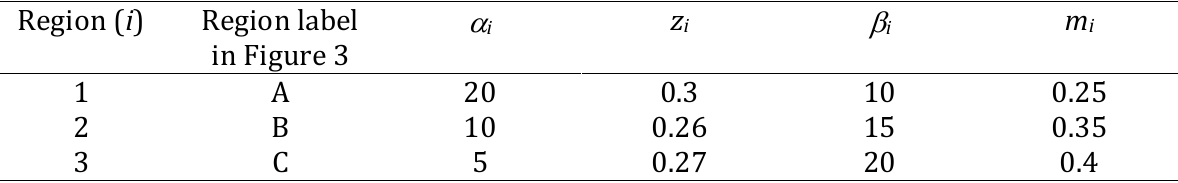
Table A1.1: Parameters used to simulate three distinct ecological regions ( i =1,2,3) and generate PPFs in Figure